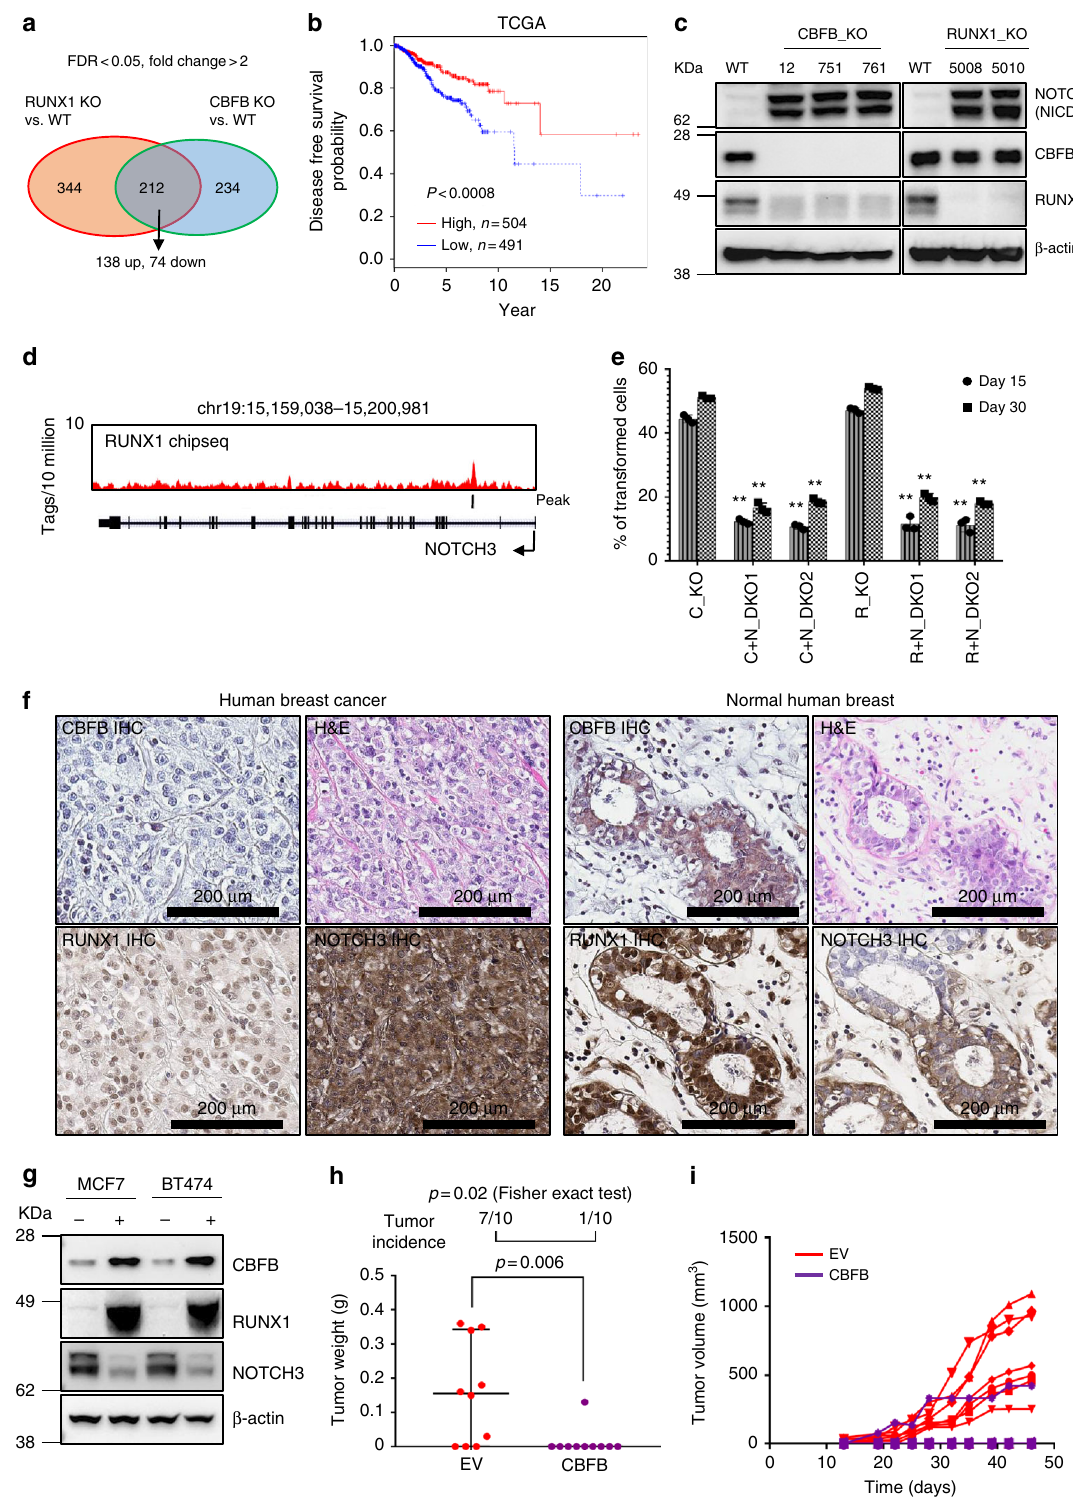
Fig. 7 The transcriptional function of CBFB is critical for breast tumor suppression. a A Venn diagram showing genes (identi fi ed by RNAseq) co-regulated by CBFB and RUNX1. b Kaplan-Meier curve showing 10-gene signature upregulated by CBFB and RUNX1 predicts disease-free survival of breast cancer patients. c IB showing the upregulation of Notch intracellular domain (NICD) of NOTCH3 in CBFB_KO and RUNX1_KO cells. d ChIPseq of RUNX1 showing the binding of RUNX1 on the NOTCH3 locus. e Anchorage independent growth assays of double knockout (DKO) of CBFB (C) and NOTCH3 (N) or DKO of RUNX1(R) and NOTCH3(N). n = 3 (biological); two asterisks, p value < 0.01 (single KO vs. double KO comparisons, two-tailed t test). f Representative IHC images showing the protein levels of CBFB, RUNX1, and NOTCH3 in human breast tumors and normal tissues. g IB showing the effect of exogenous expression of CBFB on RUNX1 and NOTCH3 expression in MCF7 and BT474 cells. h Weight and ( i ) volume of orthotopically transplanted tumors from MCF7 cells that were transduced with an empty vector (EV) or a lentiviral vector expressing CBFB (CBFB). Tumor incidence is shown on the